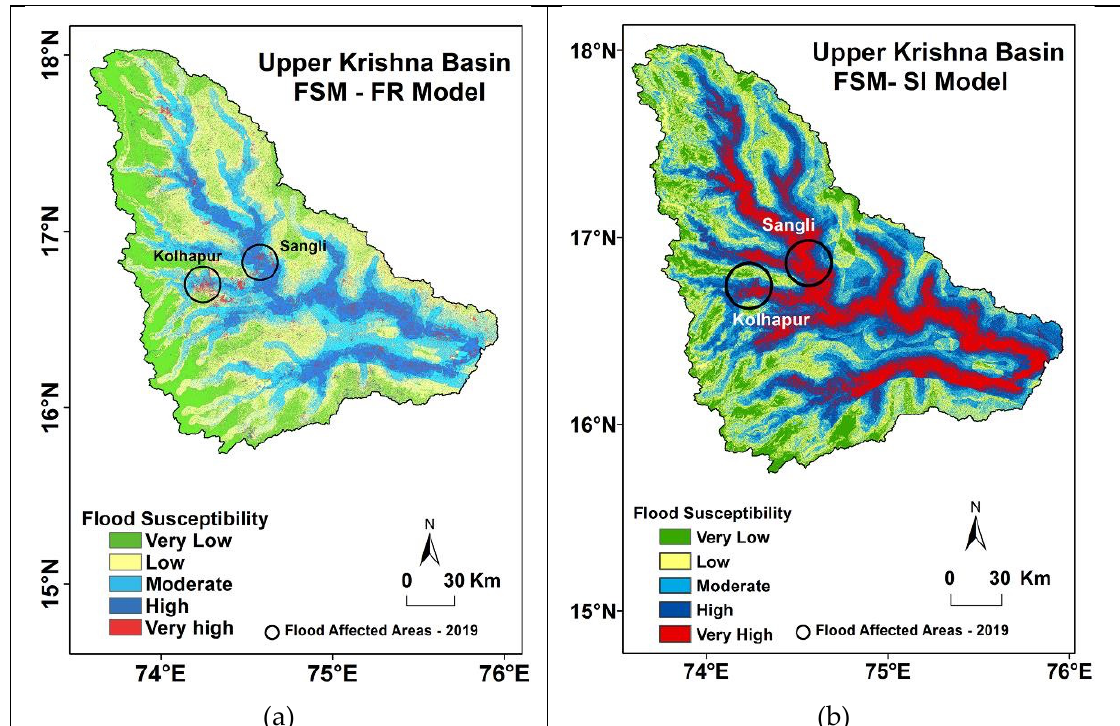
Figure 5. Flood susceptibility maps of UKB: (a) based on FR ; (b) based on SI models. Table 2. Result of the FR and SI model for different classes of the factors.